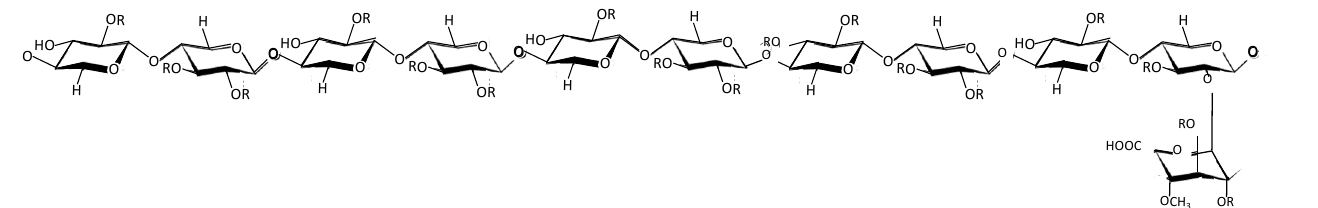
Figure 1. Structure of pentosan polysulfate showing its high sulfation density as proposed by Ghosh [6] and Ennemoser et al. [7].